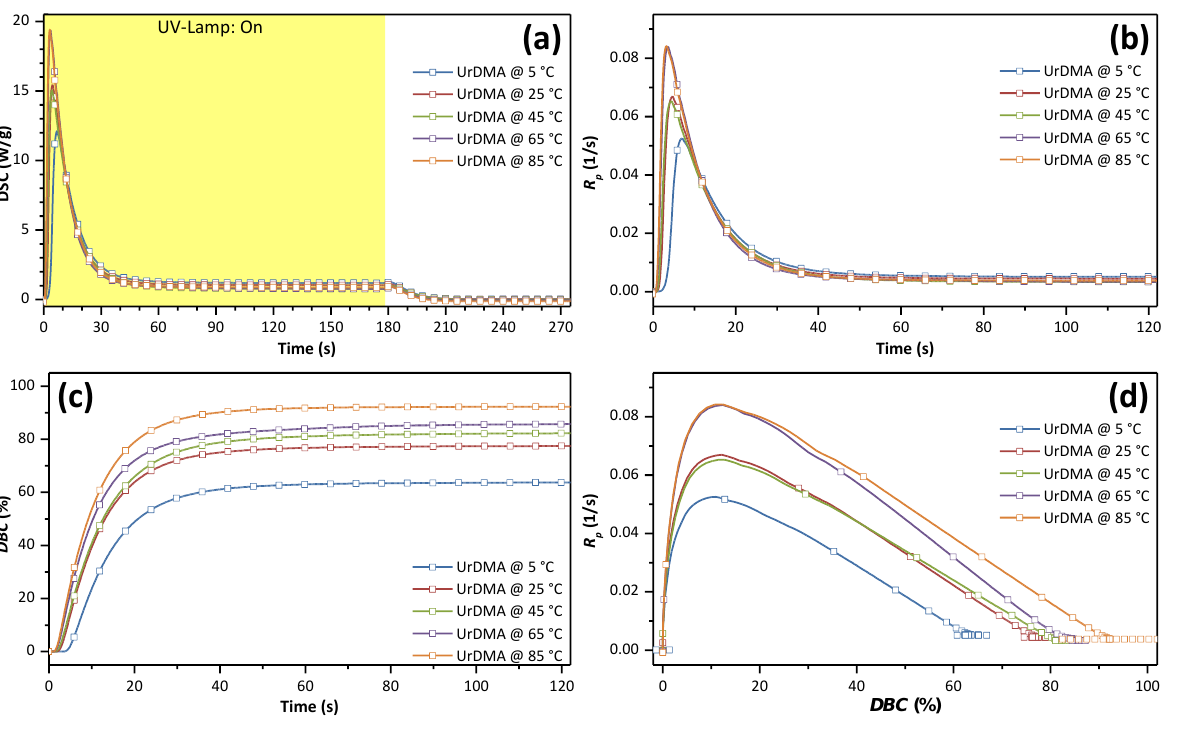
Figure 2. Photo-curing rates and conversions for UrDMA containing TPOL (1 wt.%) under N 2 atmosphere at different temperatures obtained from photo-DSC data. The intensity of the UV lamp was 1 W/m 2 . ( a ) DSC vs. time; ( b ) R p vs. time; ( c ) DBC vs. time; ( d ) R p vs. DBC .